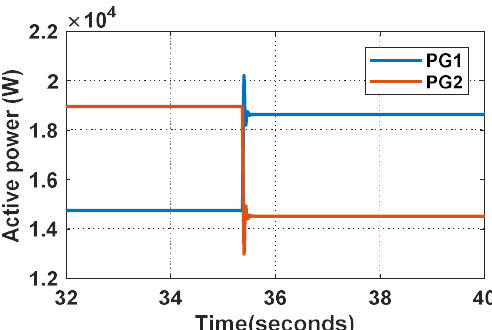
Figure 13. Output active power at DG1 and DG2.